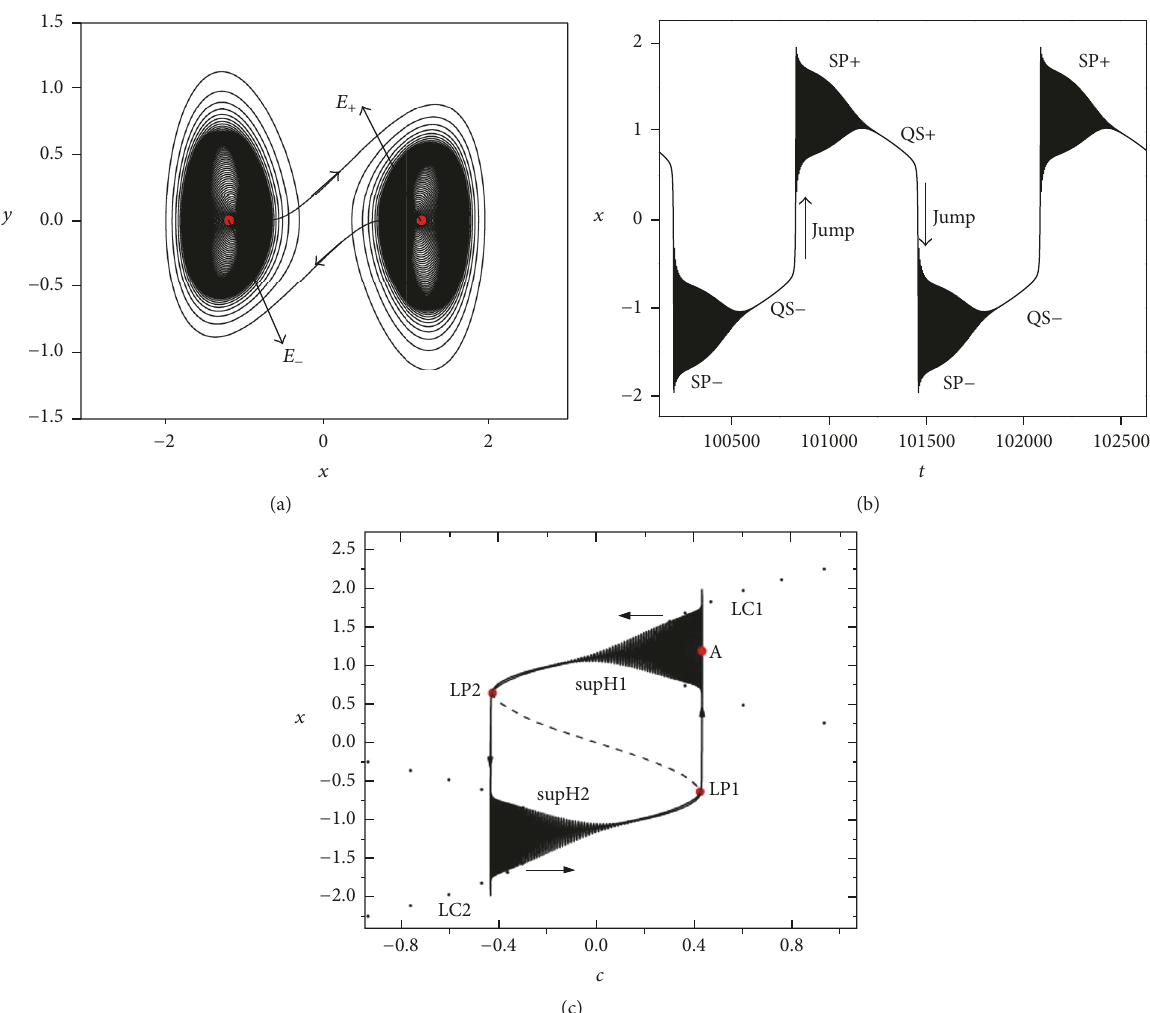
Figure 4: Bursting oscillation for 𝐴 = 0.430 . (a) Phase portrait on the (𝑥,𝑦) plane; (b) time history; (c) transformed phase portrait on the (𝑐, 𝑥) plane with the bifurcation